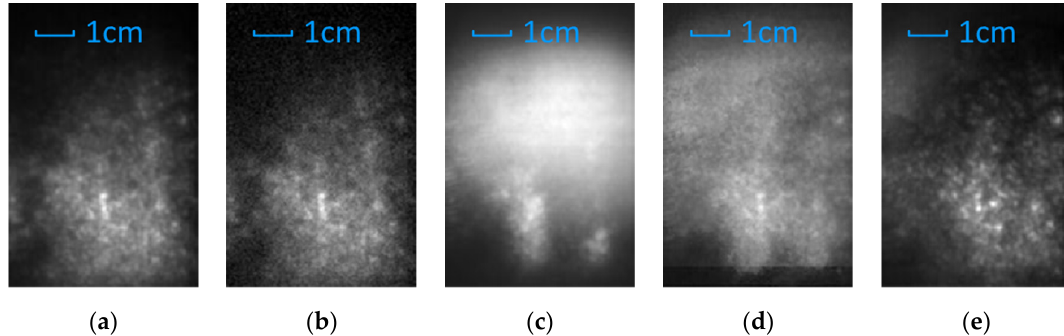
Figure 7. The reconstruction result of the reference sample and the base layer of the “idealized” multilayer sample with different methods. ( a ) The reference image. ( b ) The reference image with Gaussian noise of σ = 0.001. ( c ) The conventional LFI-SA method. ( d ) The Tao’s method based on k-means clustering. ( e ) The AIF method.